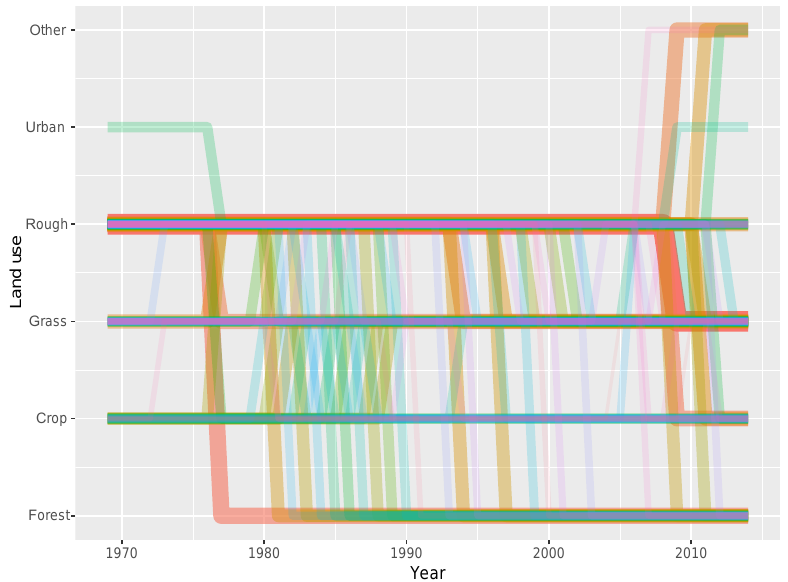
Figure 8. Trajectories of the 100 land-use vectors in the posterior U with the largest areas (excluding the six vectors which show no change). Each vector of land use is shown in a different colour, varied arbitrarily to differentiate different vectors. Line thickness and opacity are proportional to the frequency of (or total area occupied by) each vector, so that the dominant vectors are the most visually